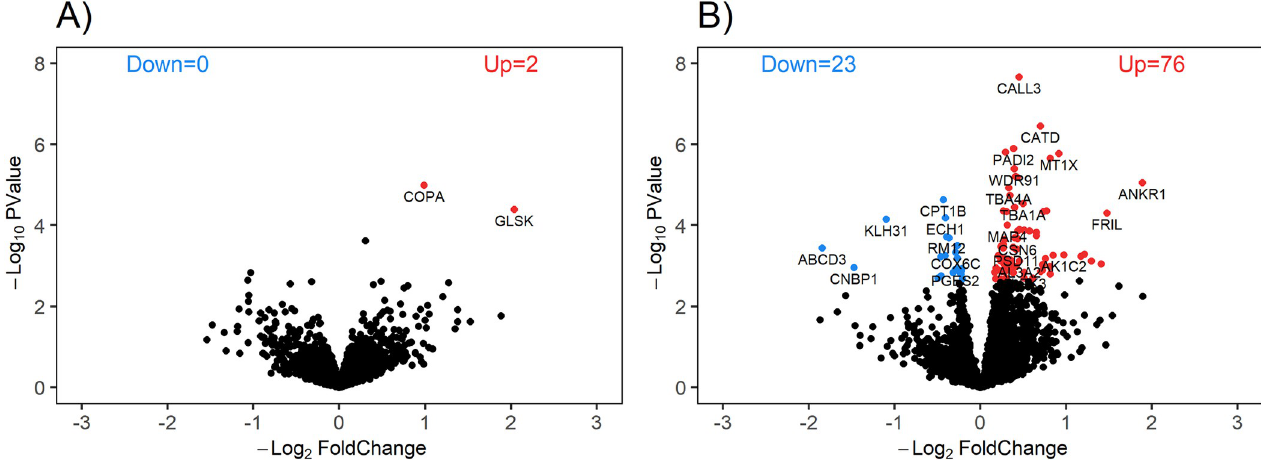
Fig 4. Volcano plot at (A) day 3 and (B) day 14, compared to baseline. Coloured datapoints represent proteins positively (red) and negatively (blue) enriched proteins meeting a threshold FDR <